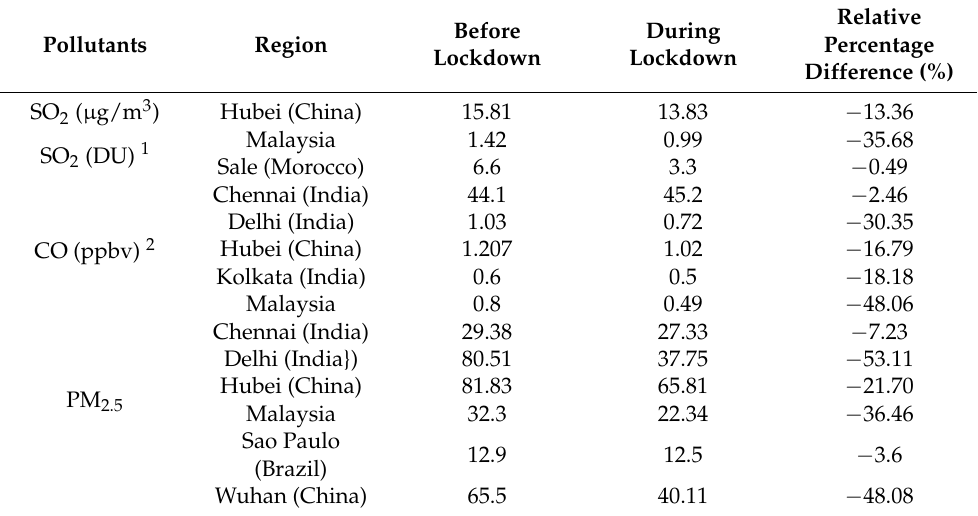
Before Lockdown